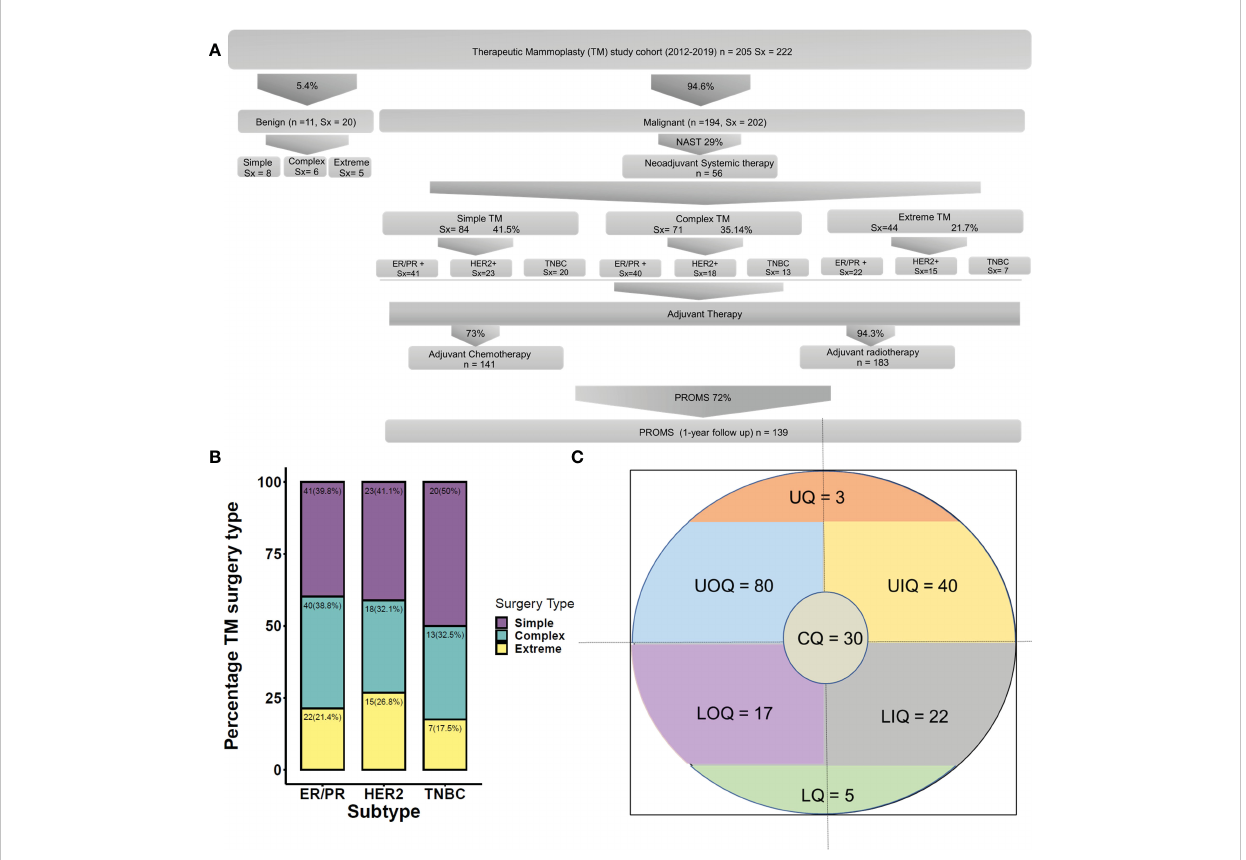
FIGURE 2 (A) Clinicopathological features of the cohort. (B) Quadrant-wise tumor location. CQ, central quadrant; LQ, lower quadrant; LIQ, lower inner quadrant; LOQ, lower outer quadrant; UIQ, upper inner quadrant; UOQ, upper outer quadrant; UQ, upper quadrant. (C) Molecular subtype-wise distribution of various TM techniques. TM, therapeutic